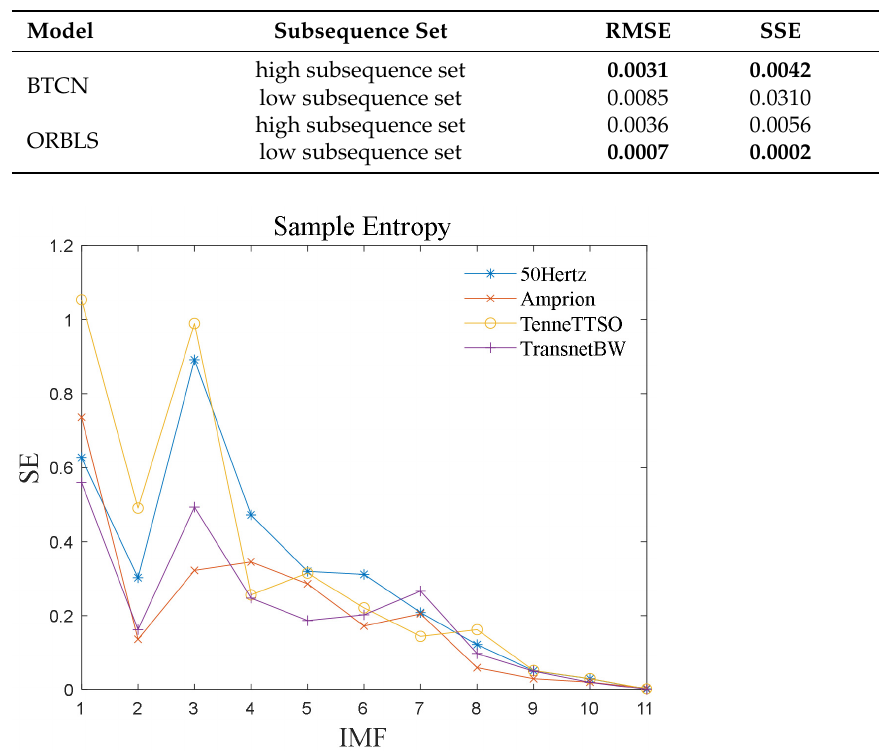
Table 5. Forecasting performances of the proposed model and reference models.